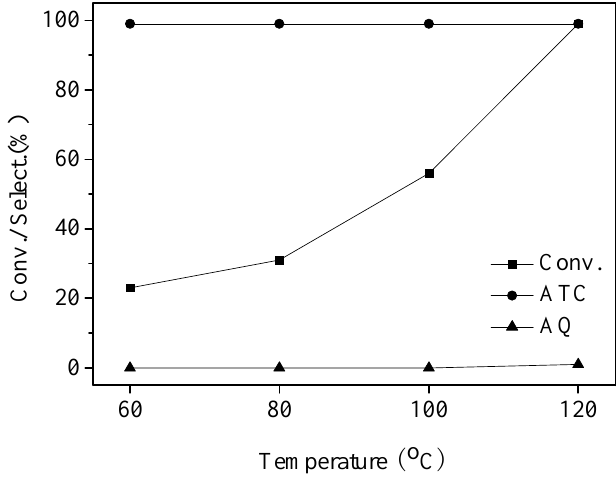
Figure 3 . Effect of reaction temperature on the oxidative dehydrogenation of 9,10- dihydroanthracene a .